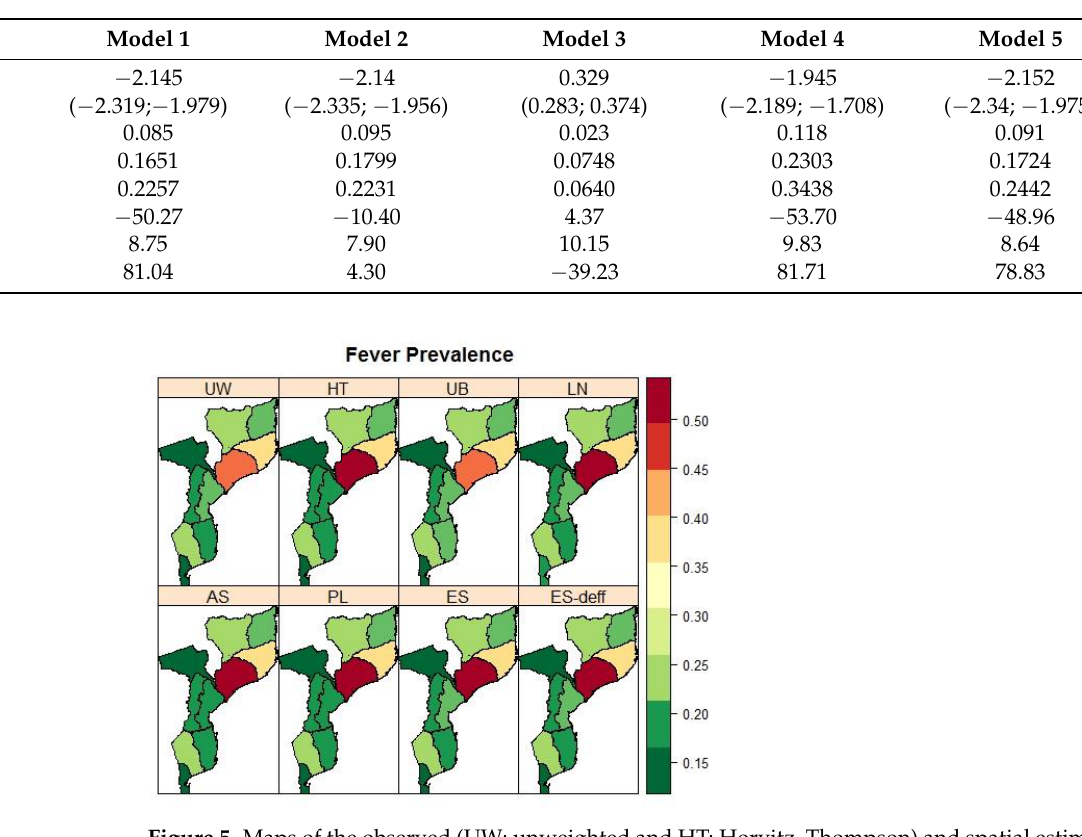
Table 5. A comparison of spatial models for mapping child diarrhoea in Mozambique using IMASIDA 2015.